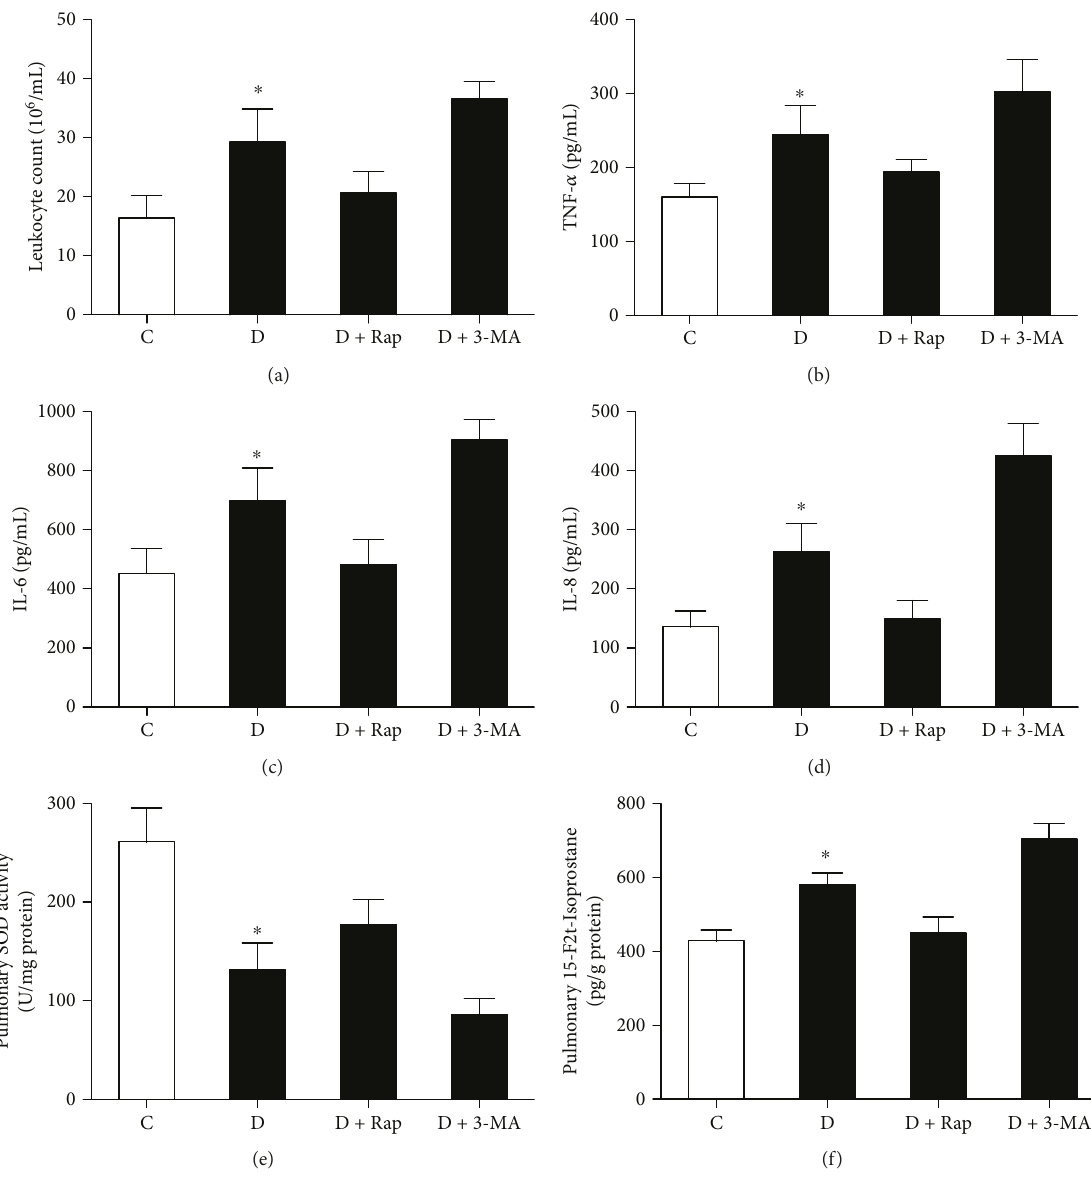
Figure 5: E ff ects of rapamycin (Rap) and 3-methyladenine (3-MA) on leukocyte count (a), TNF- α (b), IL-6 (c); IL-8 (d) in BAL fl uid; and SOD (e) and 15-F2t-Isop (f) in lung tissues from control and diabetic rats undergoing myocardial ischemia reperfusion (IR). All values are expressed as means ± S.D., n = 8 . ∗ P < 0 05 versus the other